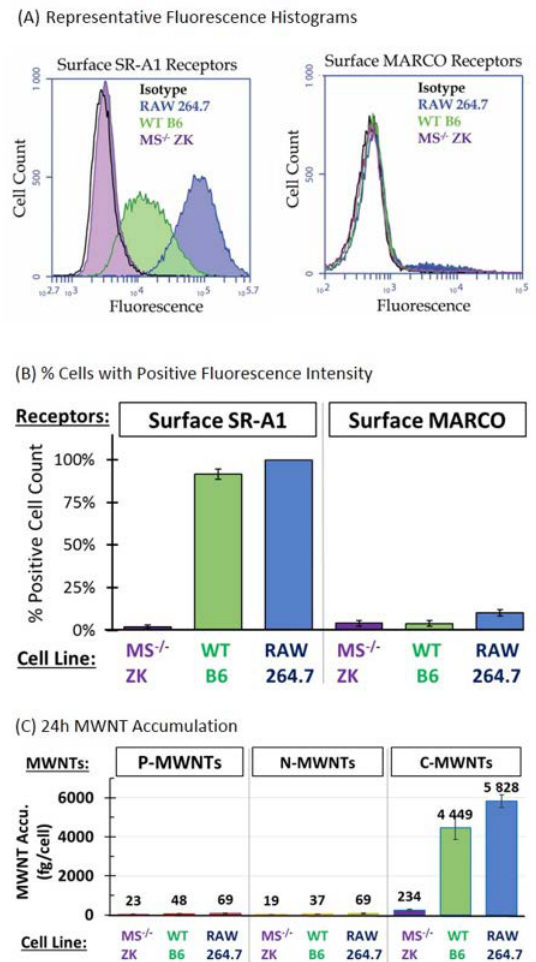
Figure 1. Surface SR-A1 receptor expression correlates with the accumulation of C-MWNTs by RAW 264.7, wild type (WT) B6, and MARCO and SR-AI / II deficient (MS) − / − ZK murine alveolar macrophages. ( A , B ) Cell surface expression of SR-A1 and MARCO receptors was determined by direct immunofluorescence FCyt assays. Cells were prepared for cytometry as described in Methods using Alexa Fluor ® 488-conjugated monoclonal anti-mouse SR-A1 or APC-conjugated monoclonal anti-mouse MARCO antibody. Cells with fluorescence intensity greater than the background isotype control were considered positive. ( A ) Representative fluorescence histograms of cells stained with anti-mouse SR-A1 (left panel) or with anti-MARCO (right panel), and corresponding isotype control antibodies. Black, isotype control; blue, RAW 264.7 cells; green, WT B6 cells; purple, MS − / − ZK cells. ( B ) The fraction of positive cells out of a total 20,000 analyzed was expressed as the % of cells positive for surface SR-A1 (left panel) or for surface MARCO (right panel) receptors. ( C ) The accumulation of P-, N-, or C-MWNTs by RAW 264.7, WT B6, and MS − / − ZK cells was determined after exposing cells to media containing 100 µ g / mL of either P-, N-, or C-MWNT for 24 h at 37 ◦ C as described in Methods. Numbers above the bars are the average fg MWNTs per cell. Data in all panels of this figure are the average ± SD of ≥ 3 independent